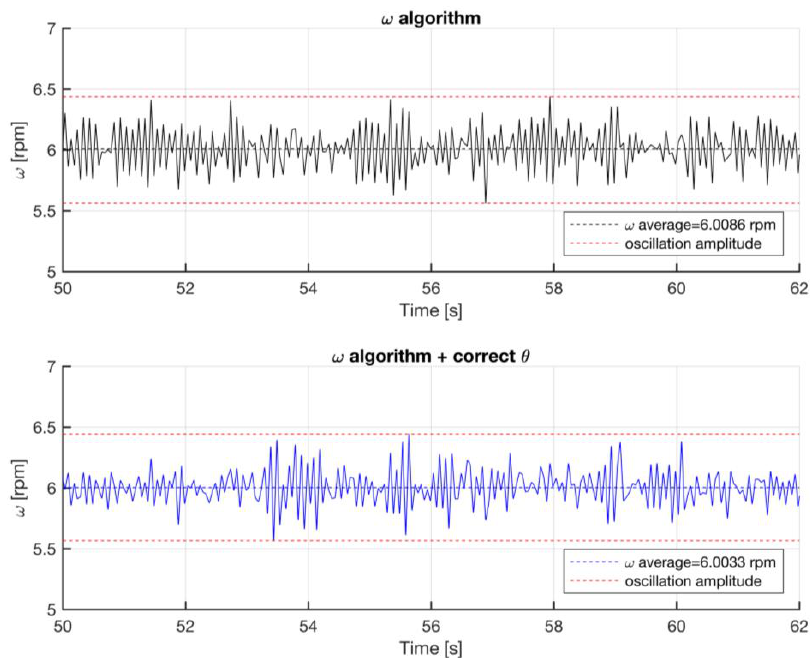
Figure 14. Bulk/void angular dispersion.